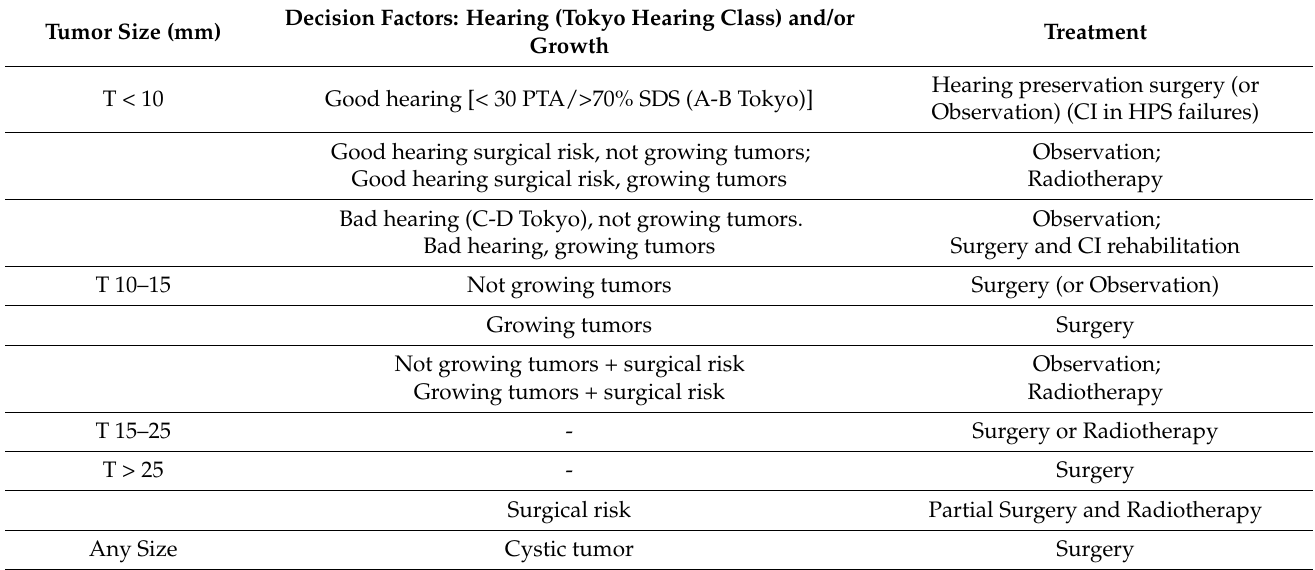
Table 3. In-home